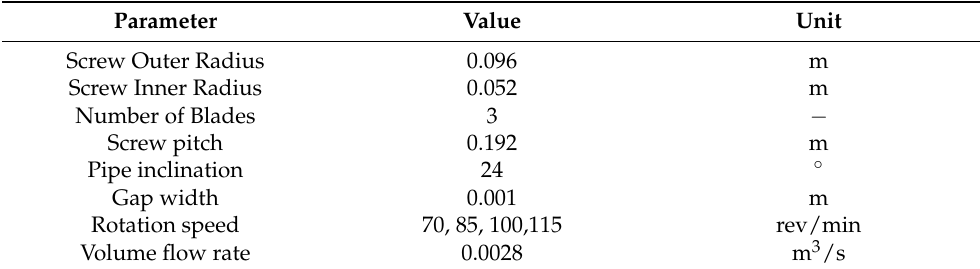
Table 2. Basic model parameters of re-validated AST model basic